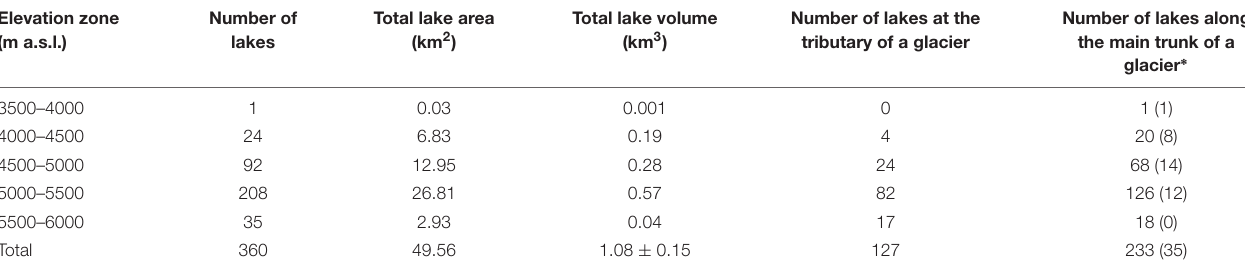
Number of lakes along the main trunk of a glacier